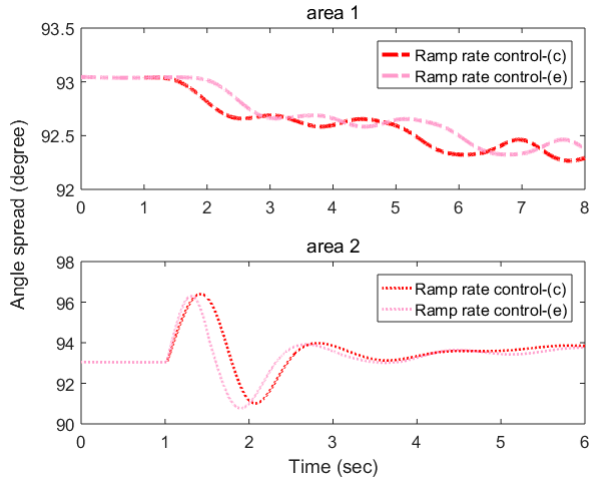
Figure 14. Angle spread results of each area according to (c) and (e) in Table 1.